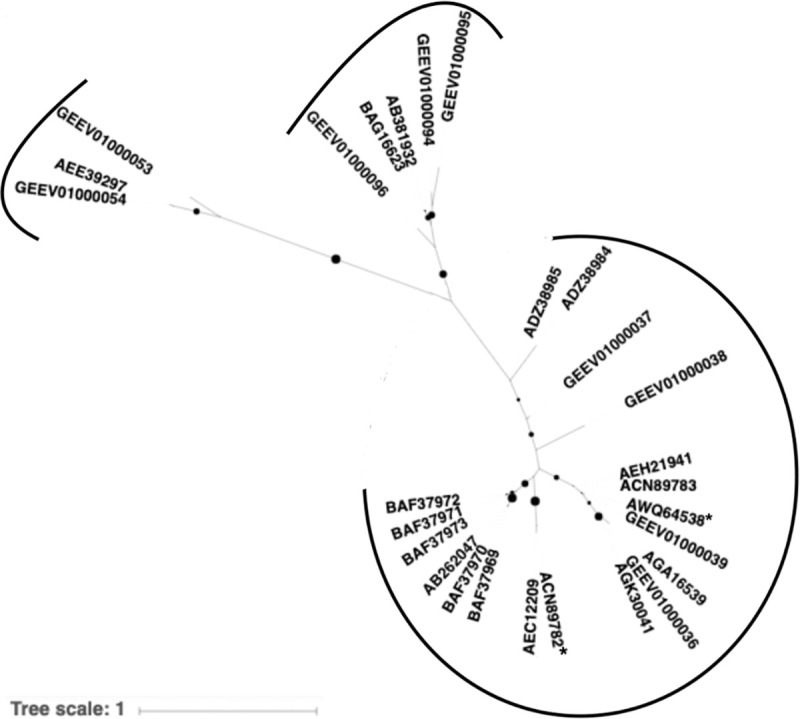
Maximum likelihood tree of 27 I-antigen sequences from C. irritans.Bootstrapping values are represented by size of black dots, with a cutoff of 70. Three distinct phylogenetic groups are indicated by black arcs, and sequences that have been used in vaccine developments are indicated with asterisks.